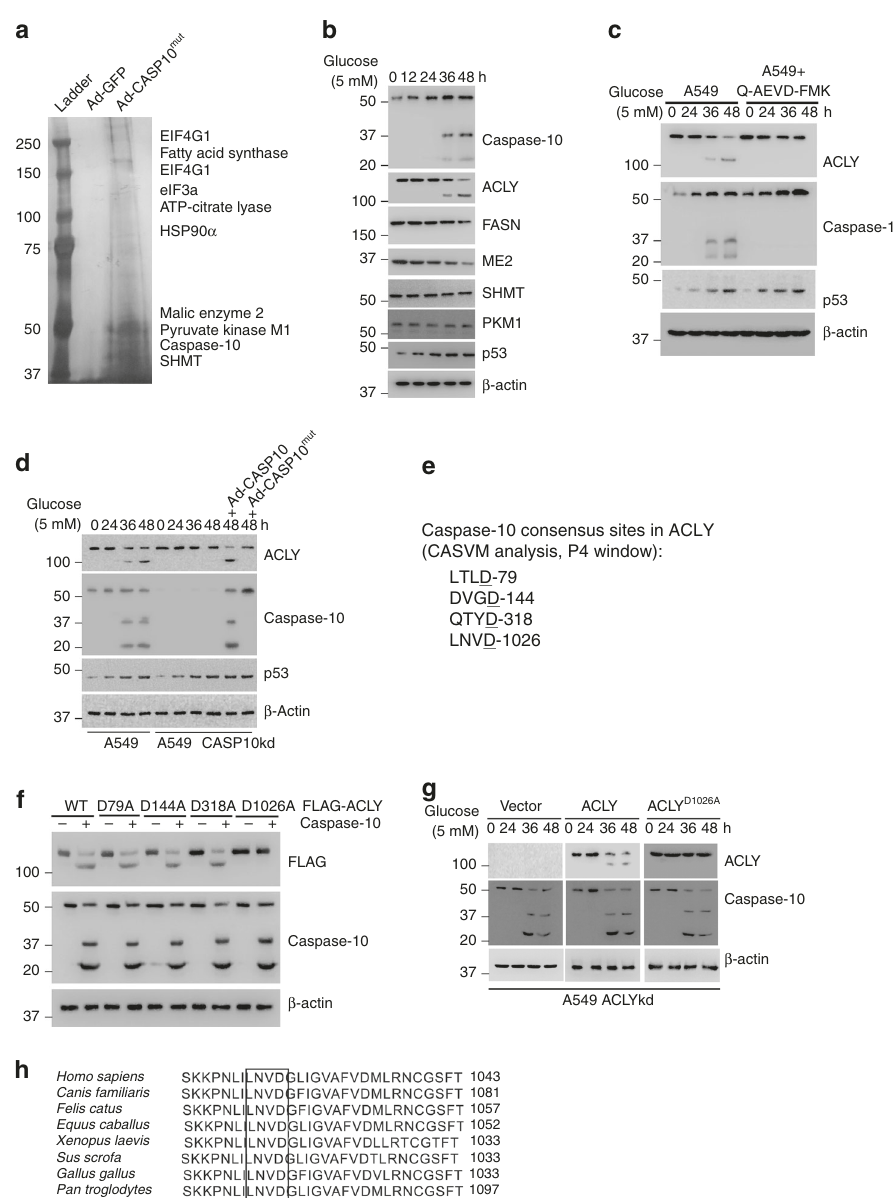
Fig. 2 Caspase-10 cleaves ATP-citrate lyase a H1299 cells were infected with adenovirus expressing GFP (Ad-GFP) or caspase-10 mut tagged with FLAG and HA epitopes (Ad-CASP10 mut ). Twenty-four hours post-infection, cell extracts were sequentially immunoprecipitated with FLAG and HA antibody af fi nity resins. The caspase-10 associated proteins were detected by SDS-PAGE and silver staining. b A549 cells were subjected to glucose starvation for the indicated time points. The cells were then harvested and western blotting was performed for the indicated proteins. c A549 cells were subjected to glucose starvation and concomitantly treated with DMSO (control) or caspase-10 inhibitor (Q-AEVD-FMK) (25 μ M) for the indicated time points. The cells were then harvested, and western blotting was performed for the indicated proteins. d A549 cells were stably transfected (pooled zeocin-resistant population) with control (scrambled) or caspase-10 shRNA. A549 control (A549) and caspase-10 knockdown (A549 CASP10kd) cells were subjected to glucose starvation for the indicated time points. A549 CASP10kd cells were infected with adenovirus expressing wild-type caspase-10 (Ad-CASP10) or catalytically dead caspase-10 mutant (Ad-CASP10 mut ) during the last 18 h prior to the end of the 48 h time point, as indicated. The cells were then harvested and western blotting was performed for the indicated proteins. e Predicted caspase-10-targeted aspartate residue(s) of ACLY from CASVM analysis. f A549 cells were co-transfected with caspase-10 and FLAG-tagged wild-type ACLY or mutants as indicated. 24 h post-transfection, the cells were harvested and western blotting was performed for the indicated proteins. g A549 cells were stably transfected (pooled zeomycin-resistant population) with ACLY shRNA. A549 ACLY knockdown cells (A549 ACLYkd) were stably transfected (pooled hygromycin-resistant population) with empty vector, wild-type (ACLY) or mutant ACLY (ACLY D1026A ). These cells were subjected to glucose starvation for the indicated time points followed by western blotting for the indicated proteins. h Sequence alignment of ACLY for caspase-10 targeted site in different organisms. Source data are provided as a Source Data fi